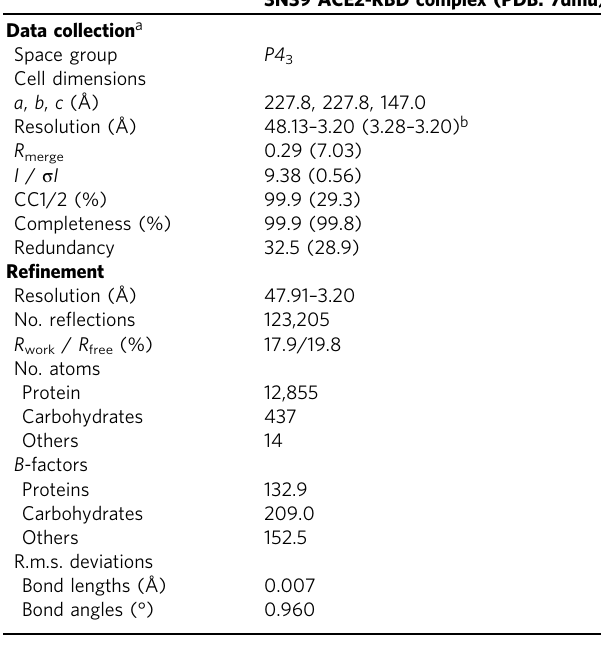
Table 1 Data collection and re fi nement